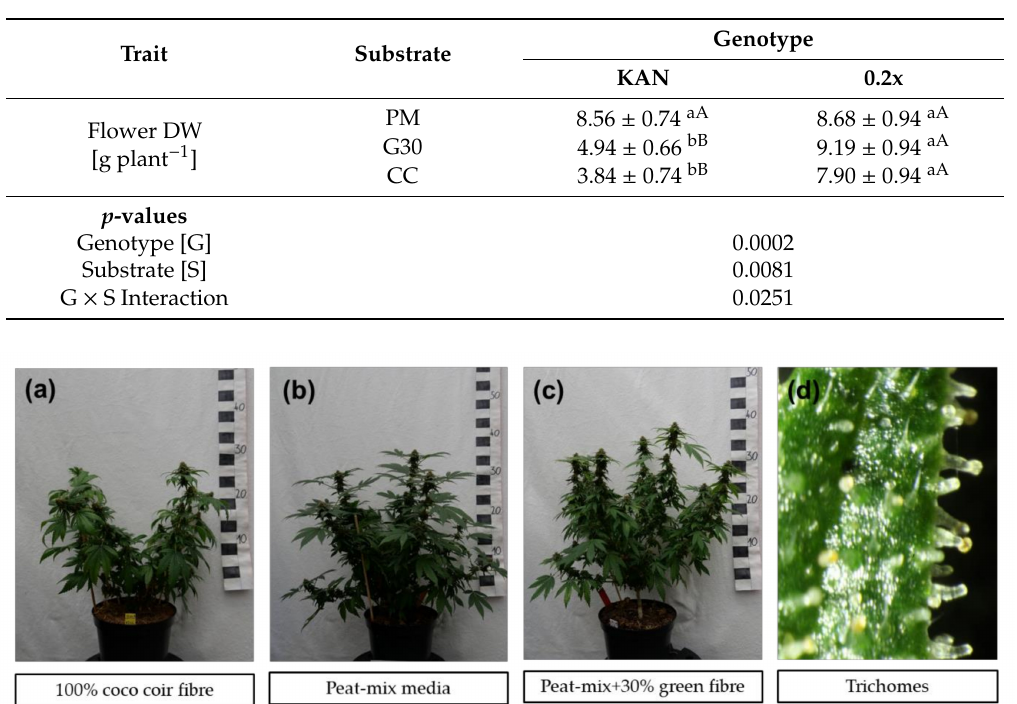
Table 3. Mean flower dry weight (DW) in g plant − 1 of genotypes KAN and 0.2x, grown on peat-mix